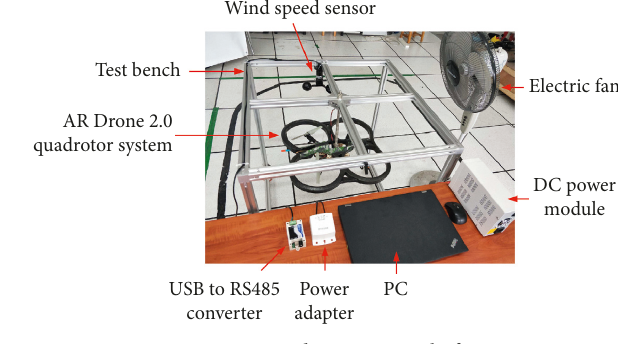
Figure 10: Quadrotor UAV platform.